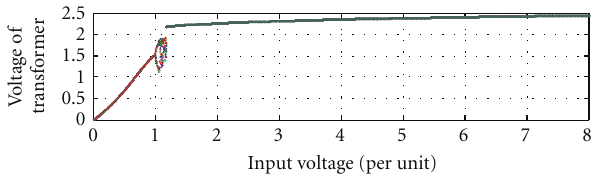
Figure 10: Time domain simulation for q = 11 (neutral resistance e ff ect).